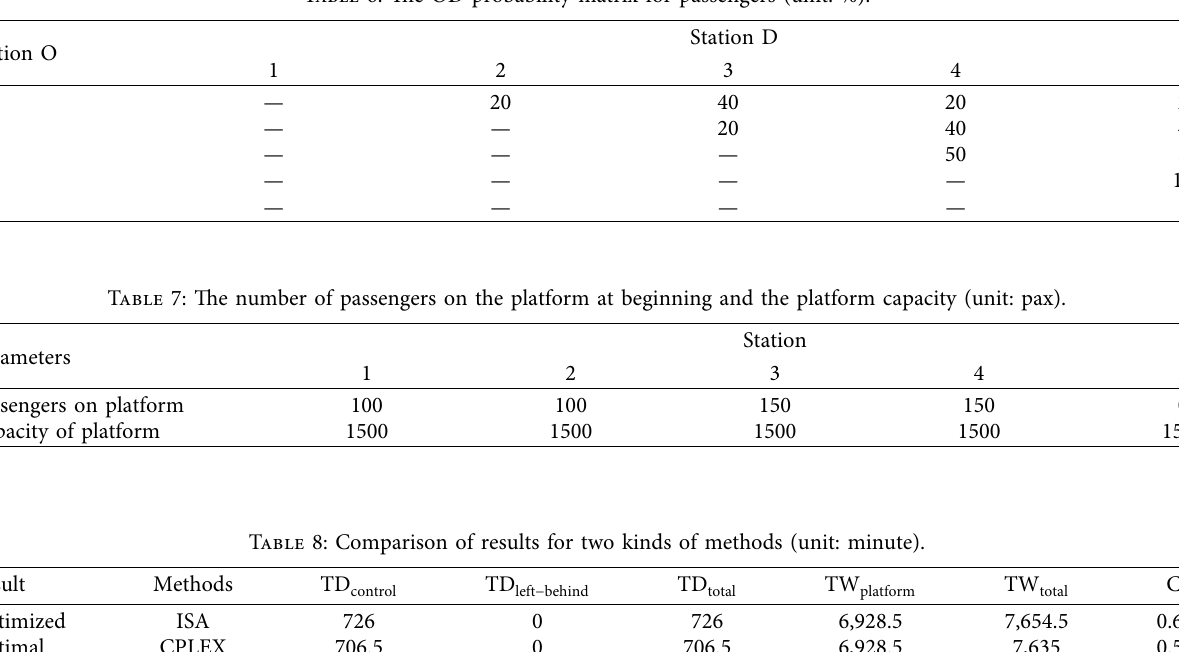
Table 6: The OD probability matrix for passengers (unit: %).